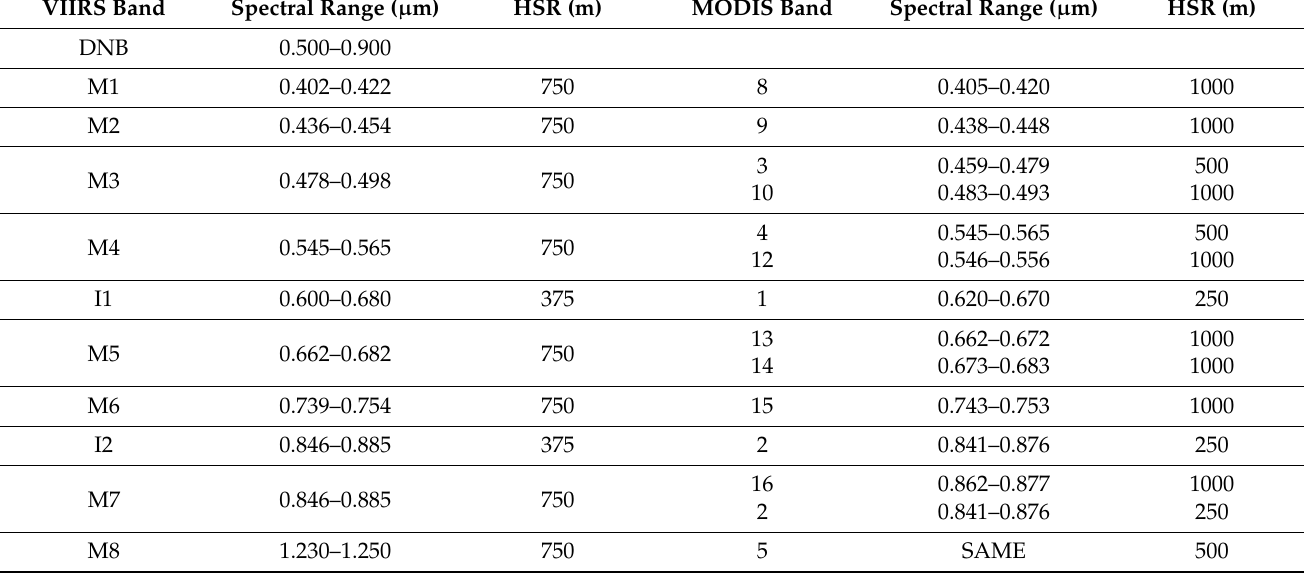
Table 1. Spectral wavelengths and spatial resolutions at the nadir of MODIS and VIIRS reflective solar bands